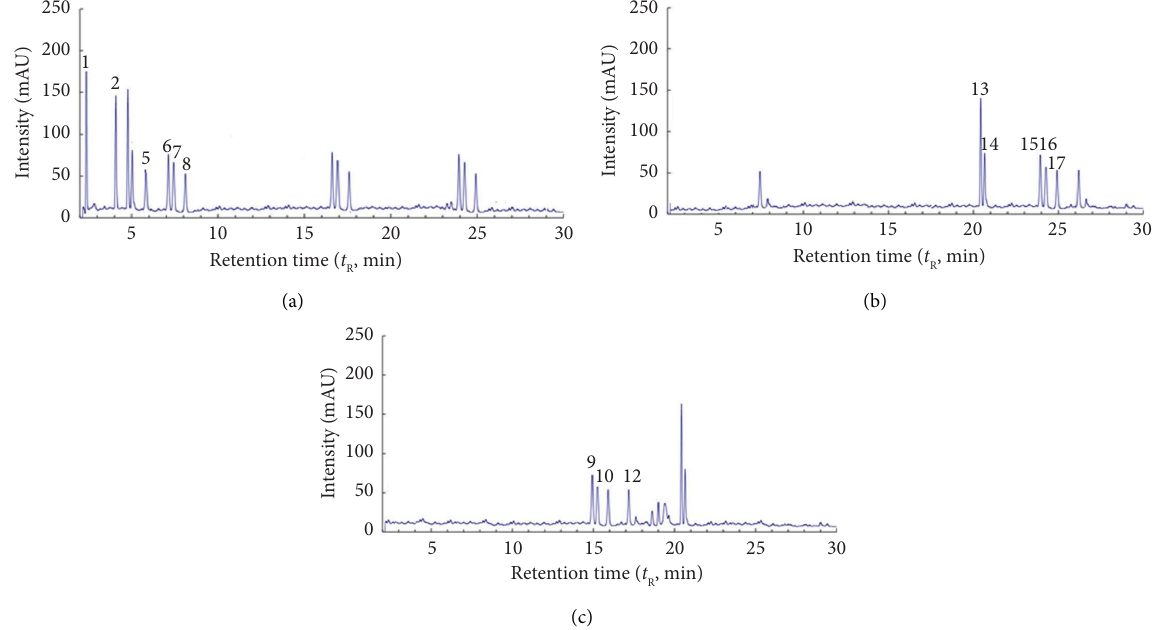
Figure 2: HPLC profles at 325nm (a), 354nm (b), and 560 nm (c) of the grape pomace extract obtained using the proline-based eutectic solvent